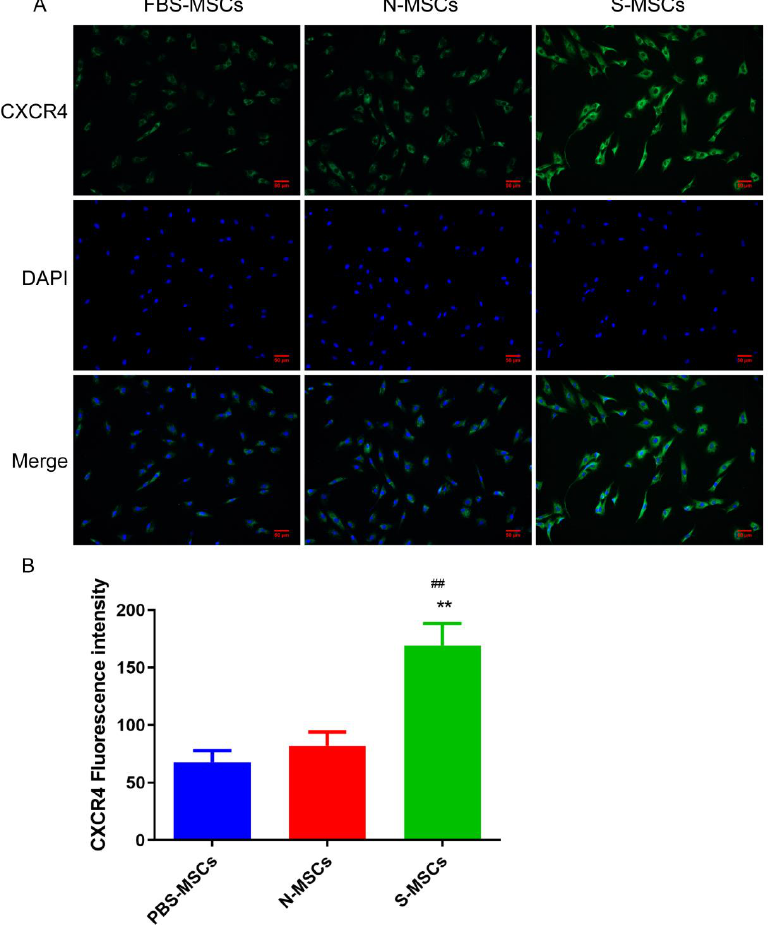
Figure 4. ( A ) Immunofluorescence detection of the expression of CXCR4 on the cell surface ( × 200), (Scale bar = 50 µ m). ( B ) Quantitative results of cell surface chemokine CXCR4 expression ( x ± s, n = 6). Compared with FBS-MSCs group, ** p < 0.01. Compared with N-MSCs group, ## p <